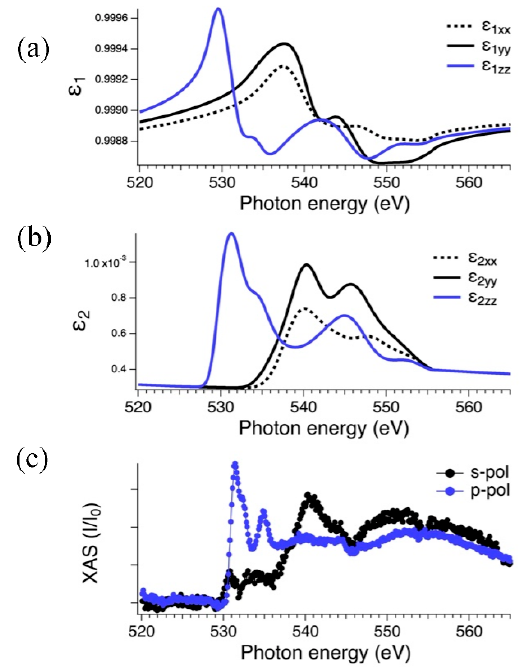
Figure 2. Calculated real ( a ) and imaginary ( b ) parts of the molecular film dielectric tensor in correspondence of the O K-edge; experimental near-edge X-ray absorption ( c ) taken in s- and p-polarization scattering condition, with a grazing incidence of 8° on a film of 2 nm of nominal coverage of PTCDA on Au(111).